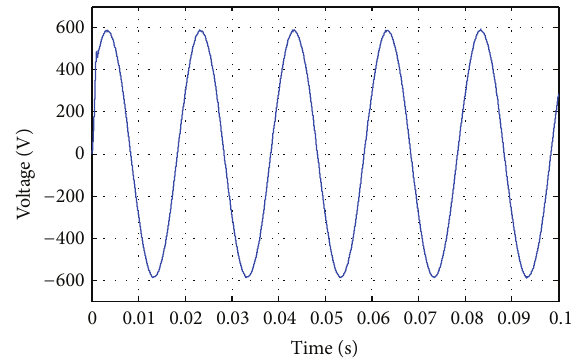
Figure 13: Line voltage ( 𝑉 𝑎𝑏 ) of the three-phase inverter with 𝑅 load.